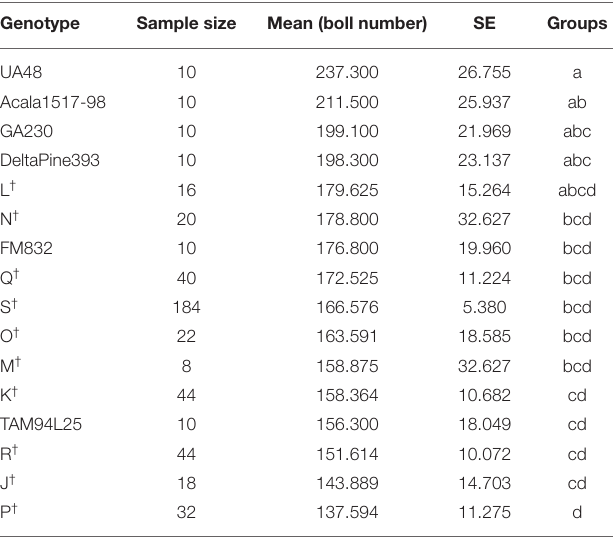
TABLE 2 | Statistical analysis summary of predicted yield for commercial cultivars and breeding